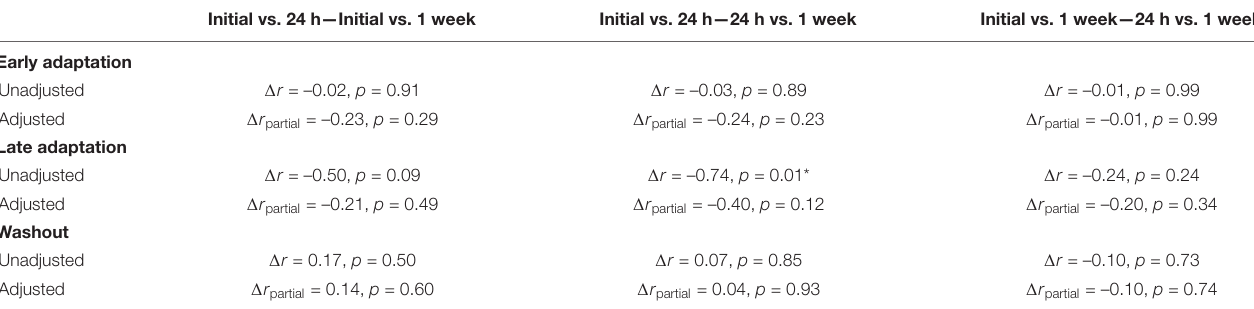
TABLE 2 | Differences in the strength of correlations between force compensation across testing